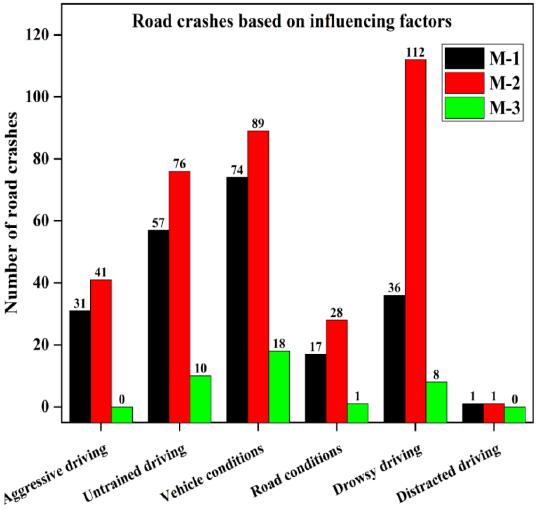
Fig. 2: Comparison of road accidents on motorways based on contributory factors